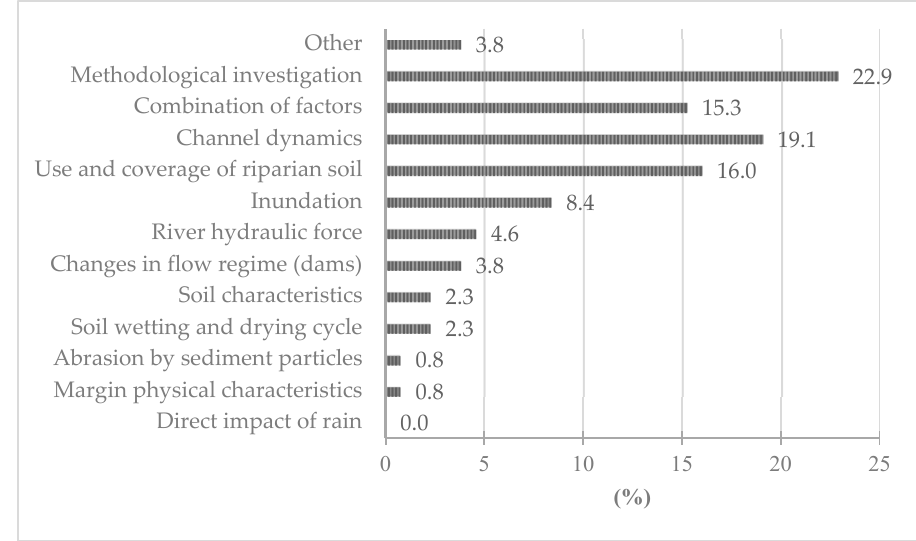
Figure 3. Distribution of investigative focuses in the literature.